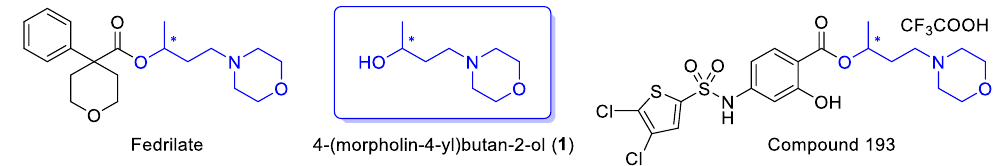
Figure 1. Structure of the cough suppressant Fedrilate and Compound 193 with antitumor activity both containing the 4-(morpholin-4-yl)butan-2-ol ( 1 ) unit as common chiral element (shown in blue and marking the center of asymmetry by the symbol *).